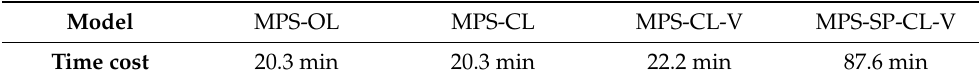
Table 3. Time cost of calculating 10,000 time steps using different models.